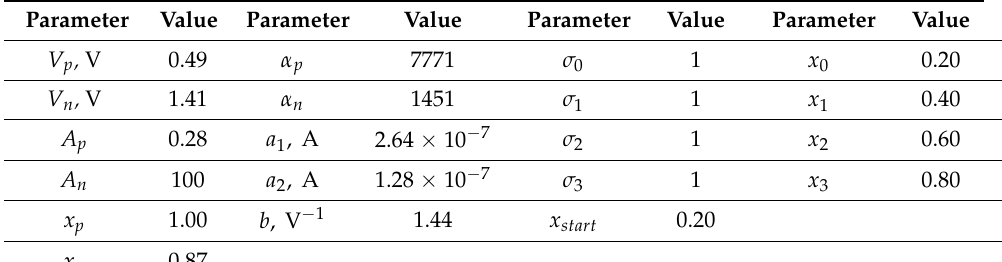
Table 7. Optimal values of the MMM model obtained by approximation of the experimental loop.